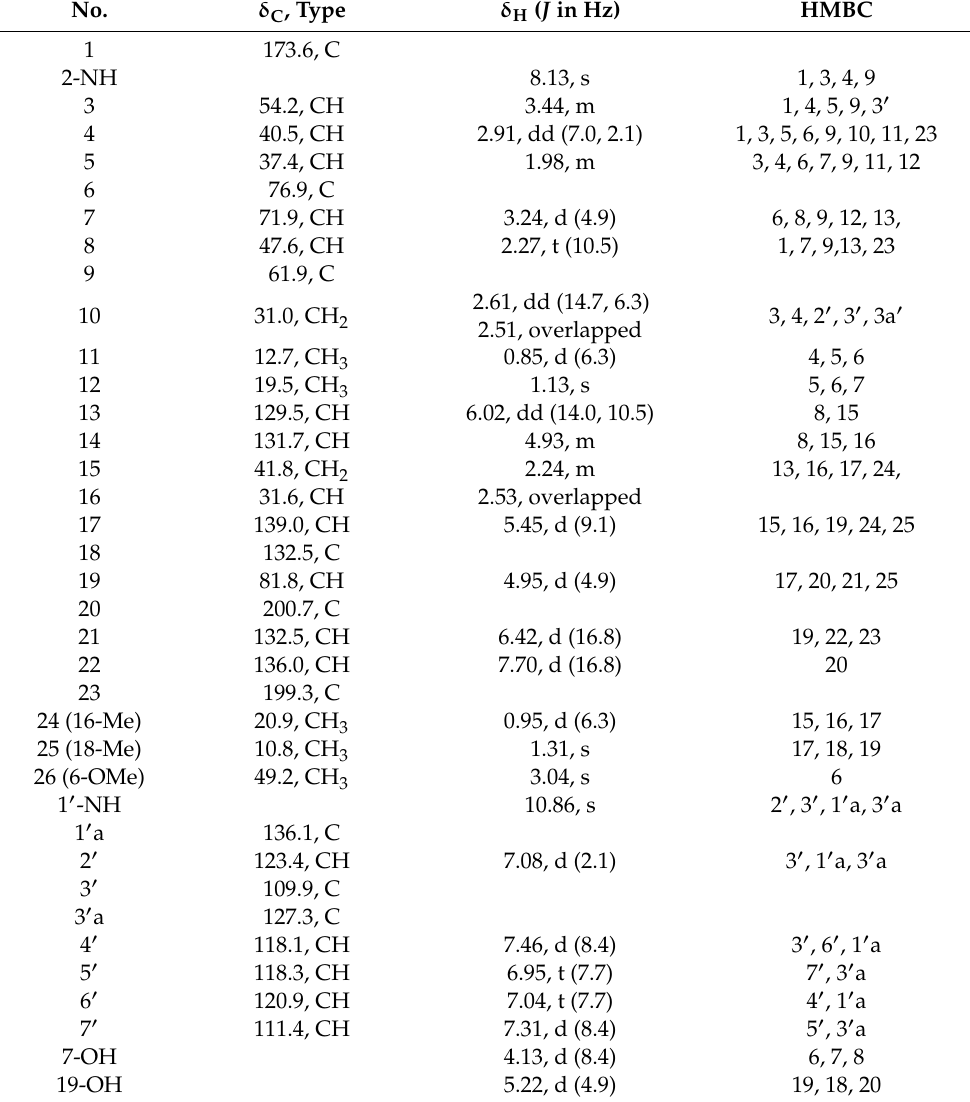
Table 1. The 1 H (700 MHz), 13 C (175 MHz) NMR and HMBC data of 1 (in DMSO- d 6